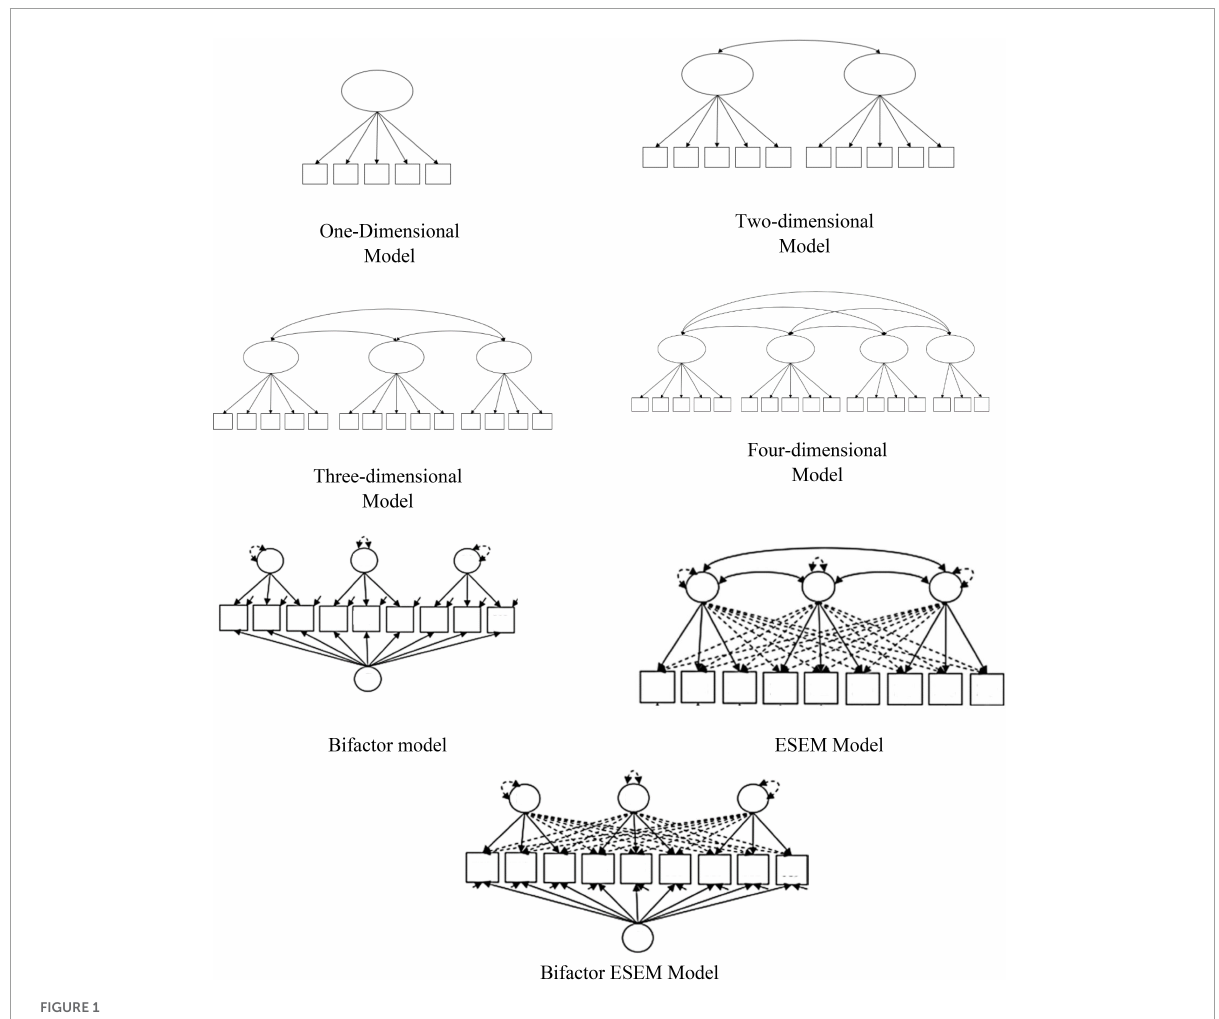
FIGURE1 PIL models evaluated.